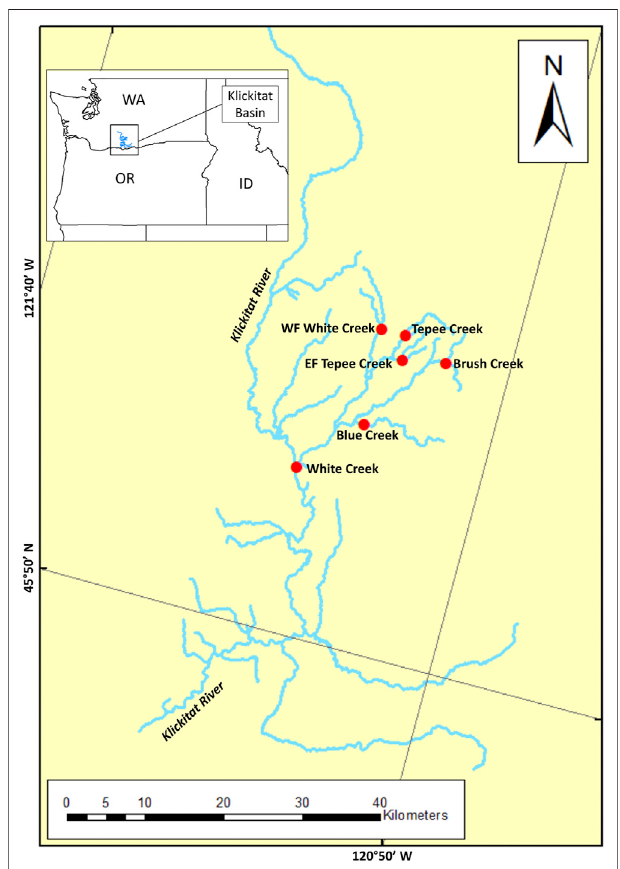
FIGURE 1 | Map of sample sites within the White Creek tributary of the Klickitat River, WA, USA, marked with a red circles. Individual samples within this tributary were identi fi ed as either resident ( n = 78) or anadromous ( n = 39) on the basis of tracking migratory fi sh patterns with passive integrated transponder (PIT)